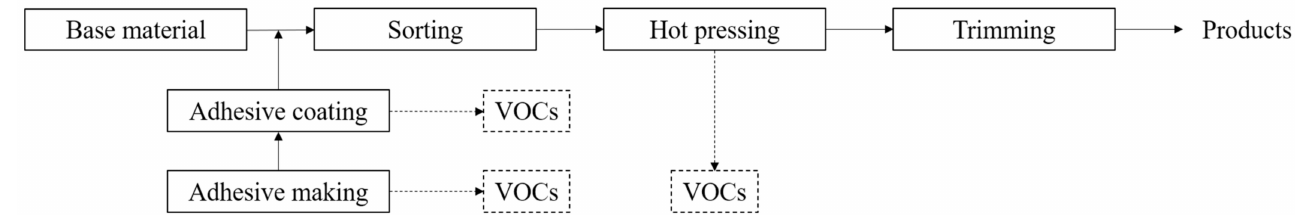
Figure 1. The typical manufacturing processes of the plywood industry in this